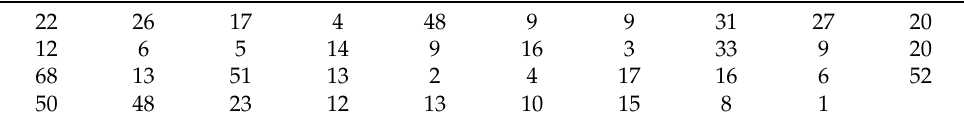
Table 6. Number of motor vehicle accident deaths in South Carolina.